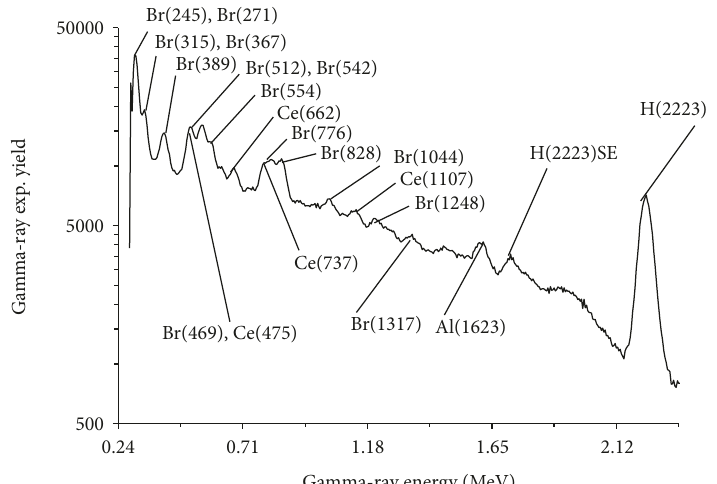
Figure 6: Prompt gamma-ray spectrum due to activation of the CeBr detector along with hydrogen capture peak from the moderator. elements present in the CeBr 3